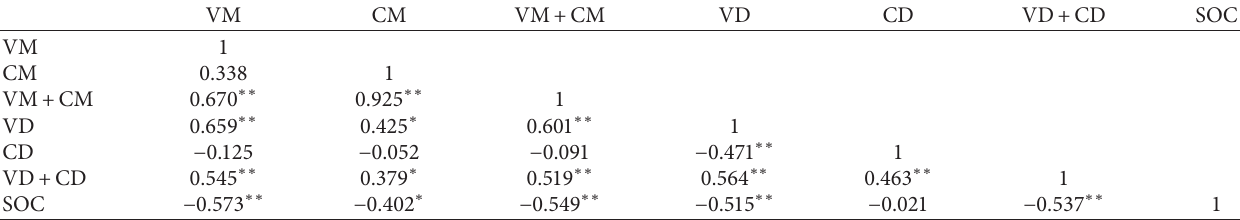
Table 7: Correlation matrix between SOC and Munsell color